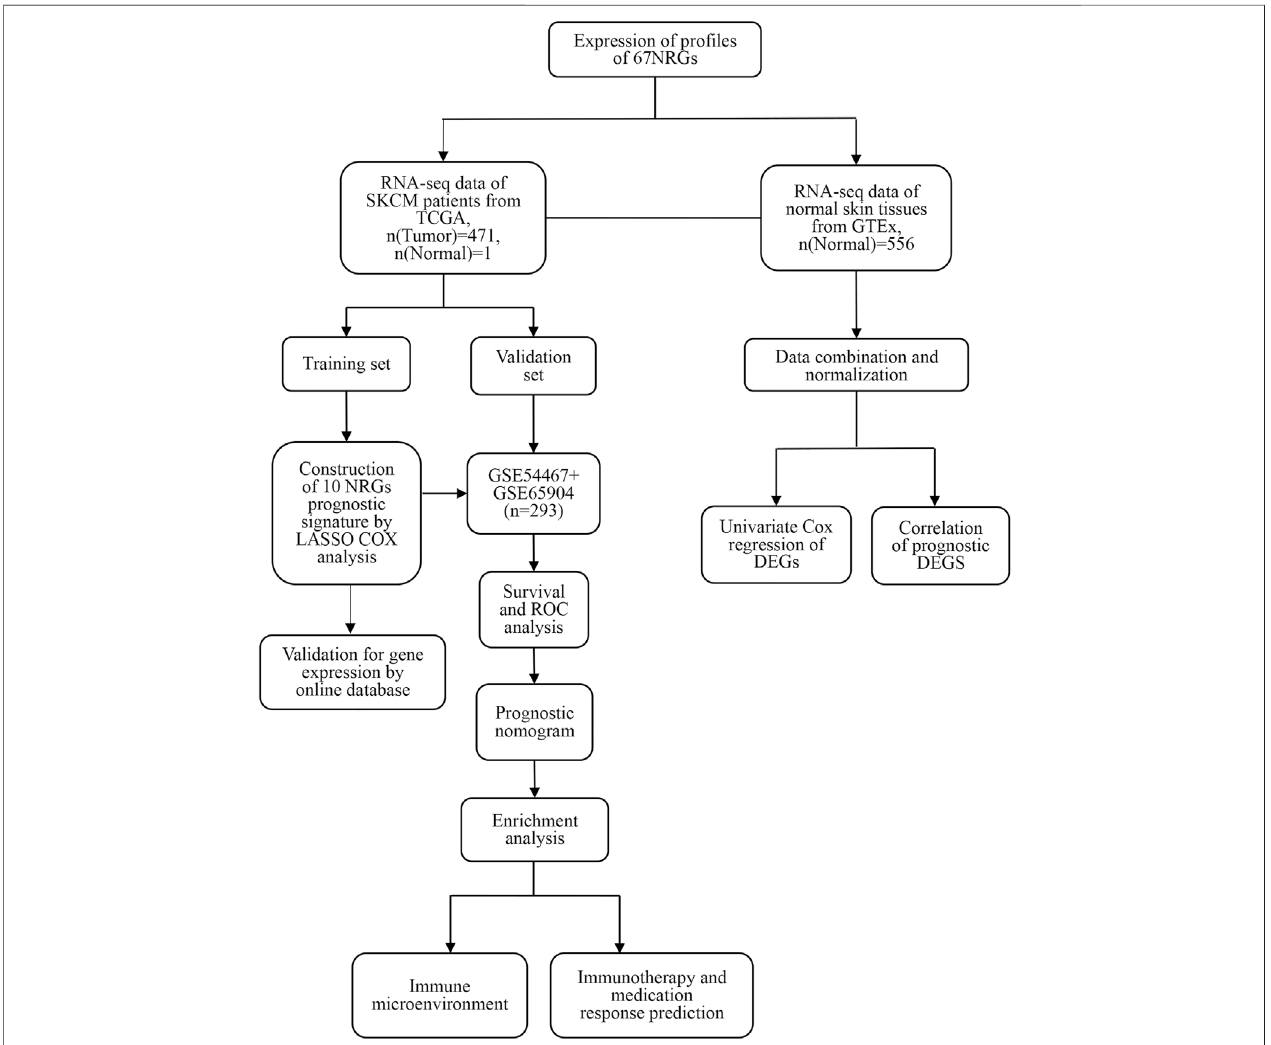
FIGURE 1 | The study work fl